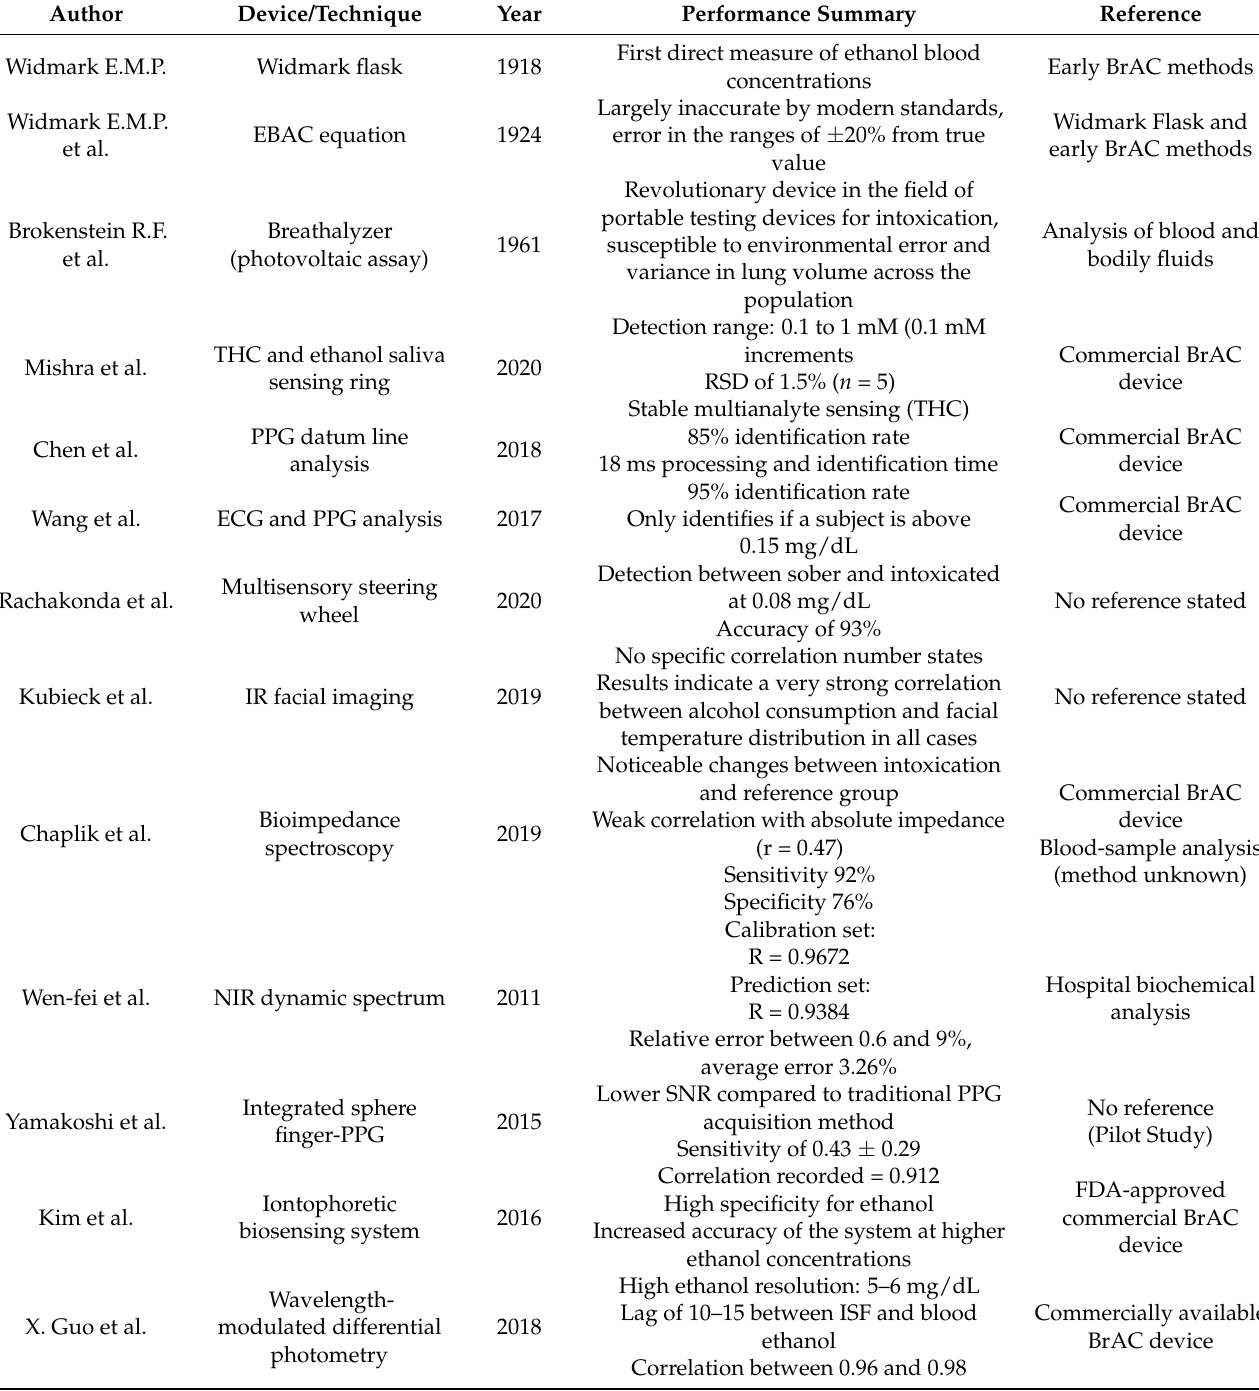
Table 2. Performance of the most notable experimental devices and